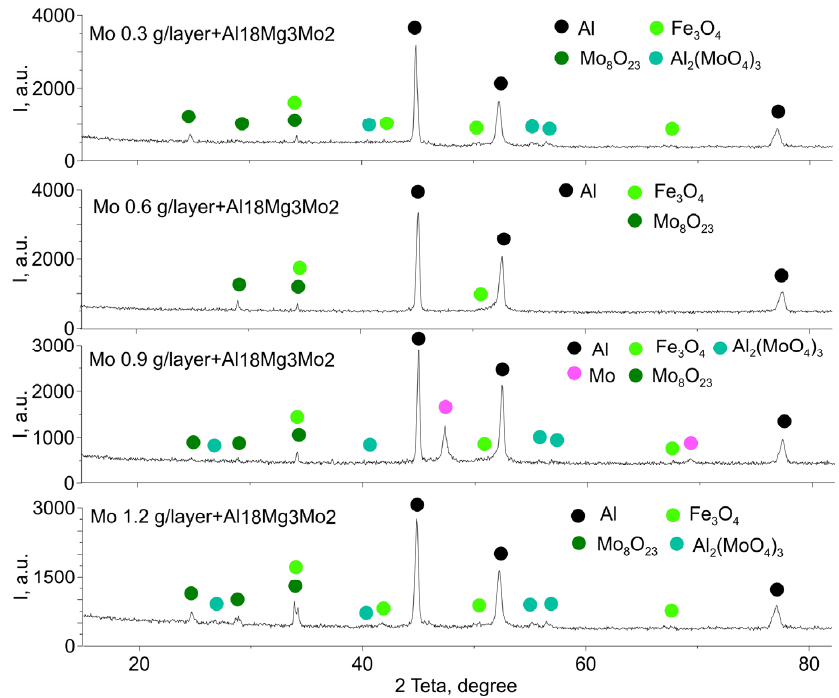
Figure 18. The glancing X-ray diffractograms of worn surface of AA5154/Mo with incidence angle 10°.